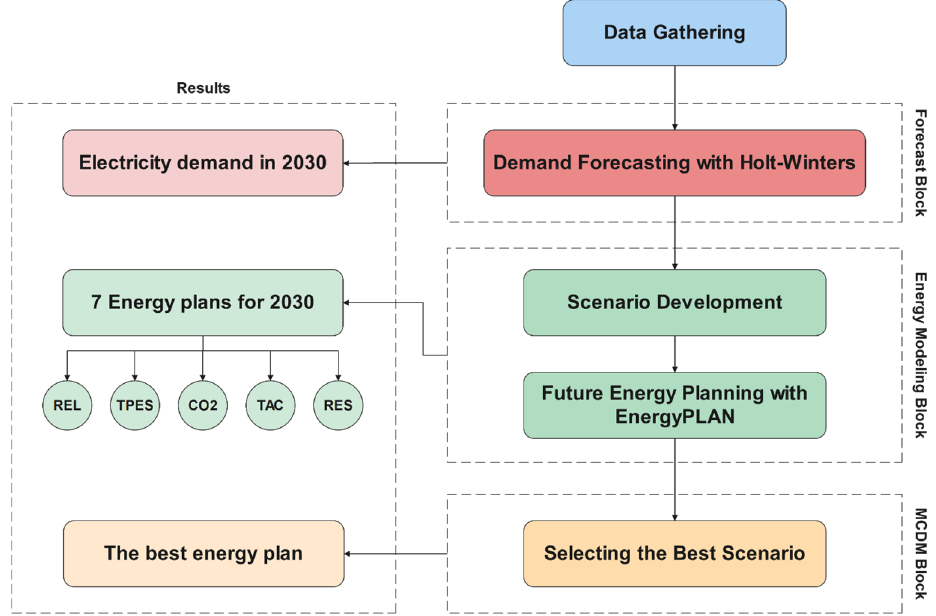
Figure 4. the research flow diagram.